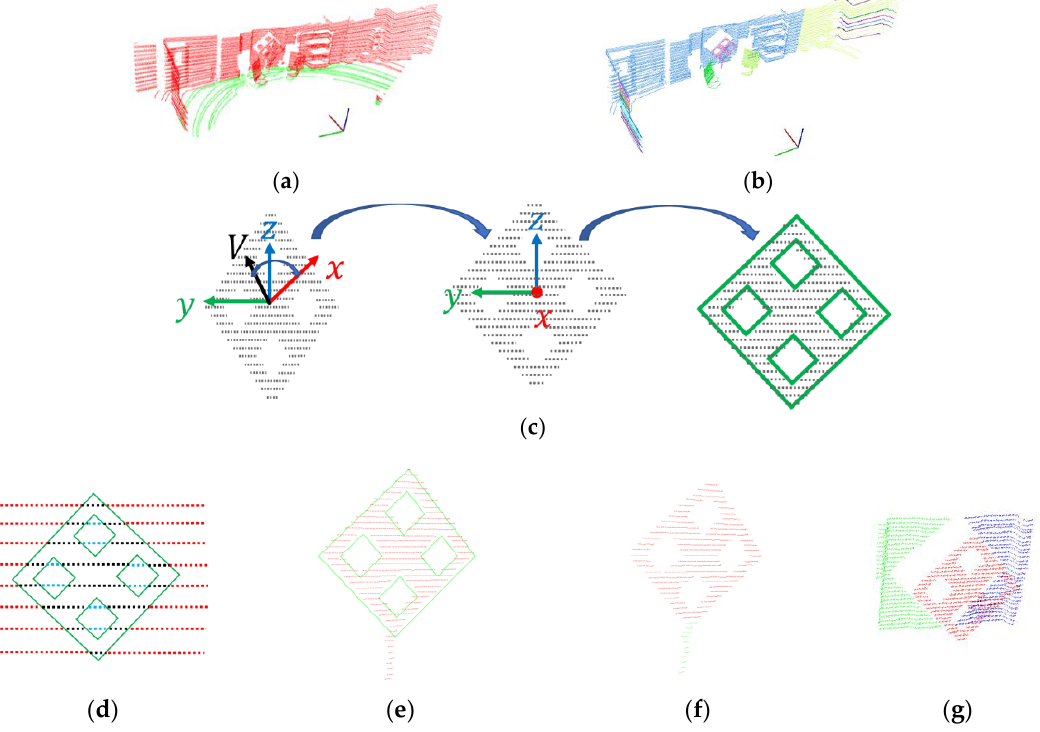
Figure 3. Automatic locating calibration object processing procedure. ( a ) is the point clouds with ground, ( b ) is the result of clustering, ( c ) is a schematic diagram of 3D to 2D conversion, ( d ) is an auxiliary diagram for locating, ( e ) is the point clouds with the highest matching score, ( f ) is the point clouds after removing the connecting rod, ( g ) is point clouds of calibration board (red points) and background point clouds (green and blue points).